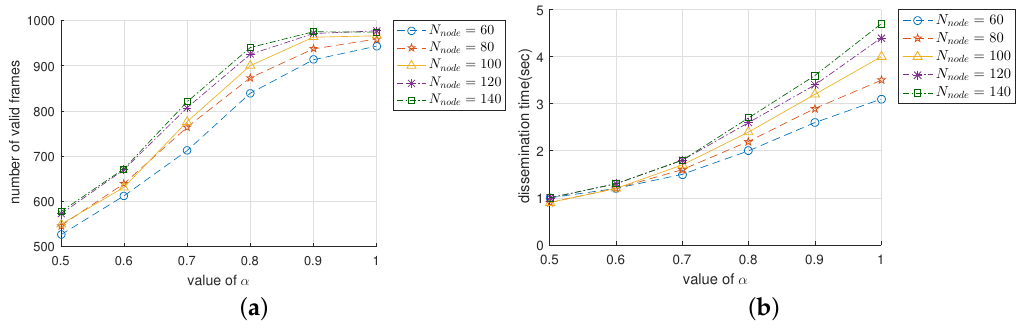
Figure 9. The effect of α on the performance of DRBF in terms of ( a ) the number of valid frames F val and ( b ) dissemination time T dis